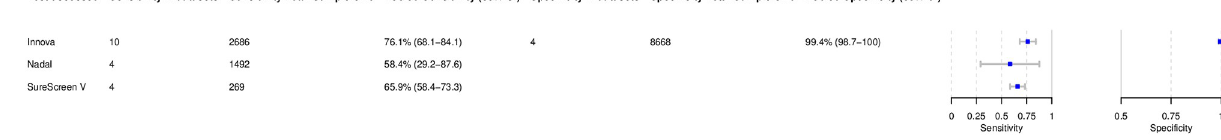
PLOS Medicine| https://doi.org/10.1371/journal.pmed.1003735 August 12,